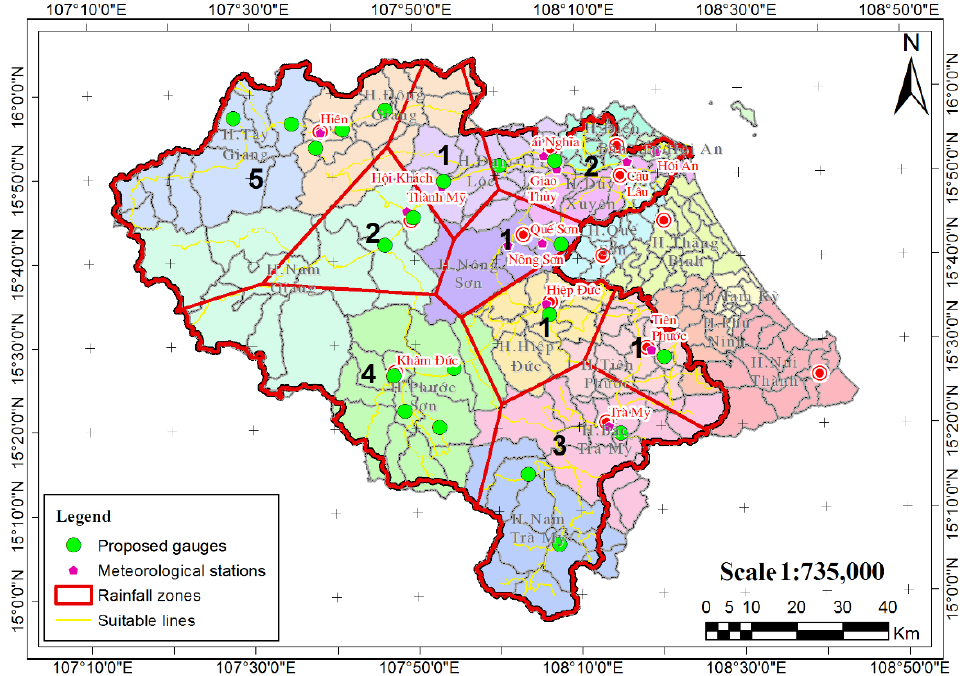
Figure 3. Meteorological stations network on the Vu Gia-Thu Bon river basin [22] (reproduced with permission from Nguyen Thi Hong, Phan Thi Thanh Truc, Nguyen Duy Liem, and Nguyen Kim Loi, International Journal on Advanced Science Engineering Information Technology; published by Indonesian Society for Knowledge and Human Development, 2016).